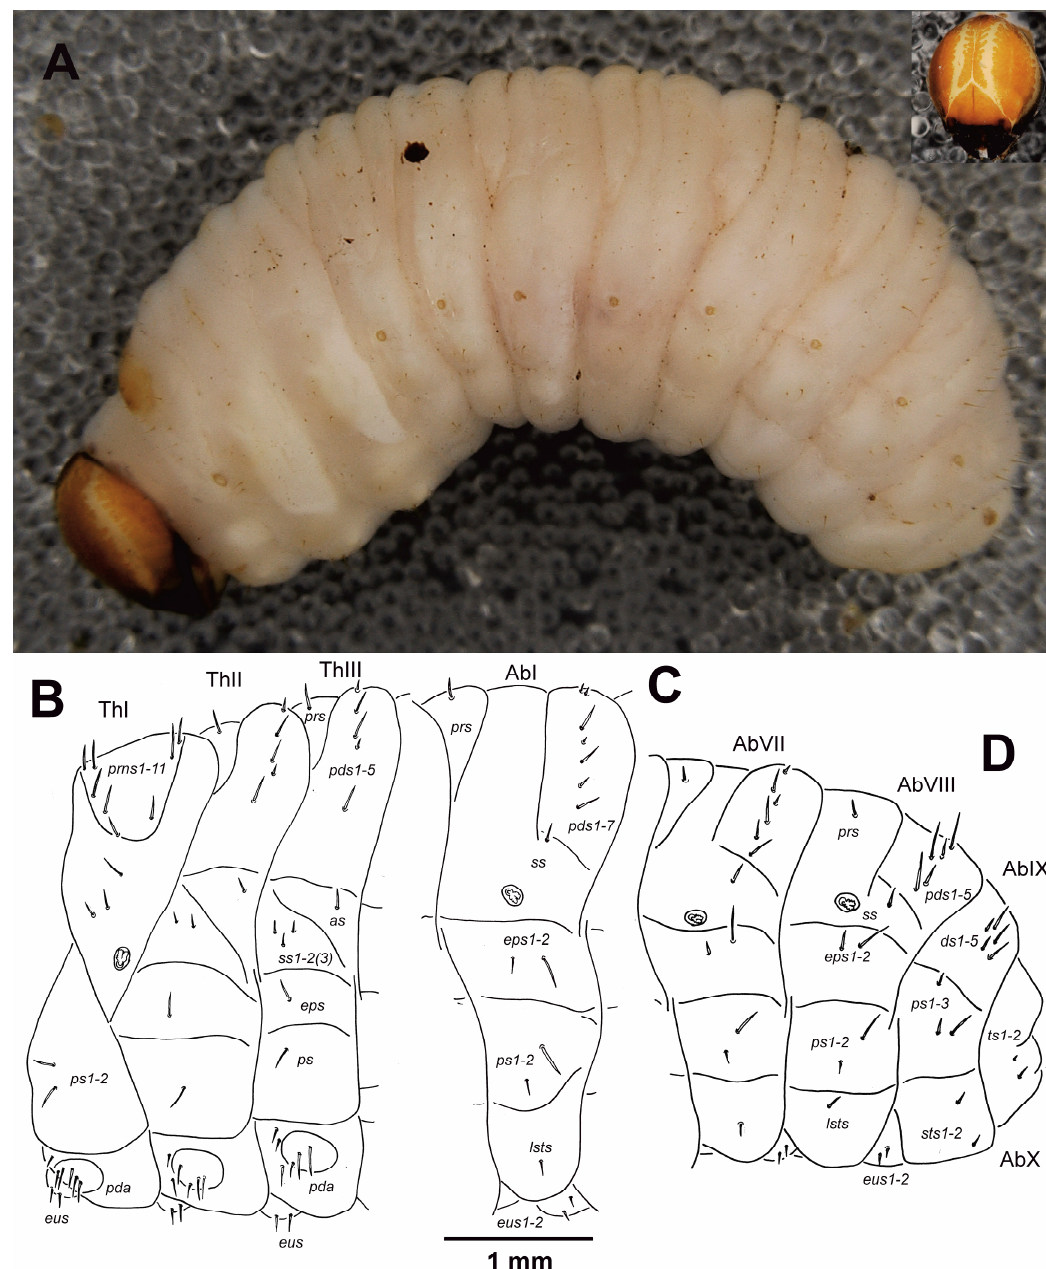
Figure 1. Cleonis pigra mature larva, habitus. ( A )—shape of the body (lateral view); ( B )—lateral view of thoracic segments; ( C )—lateral view of abdominal segment II; ( D )—lateral view of abdominal